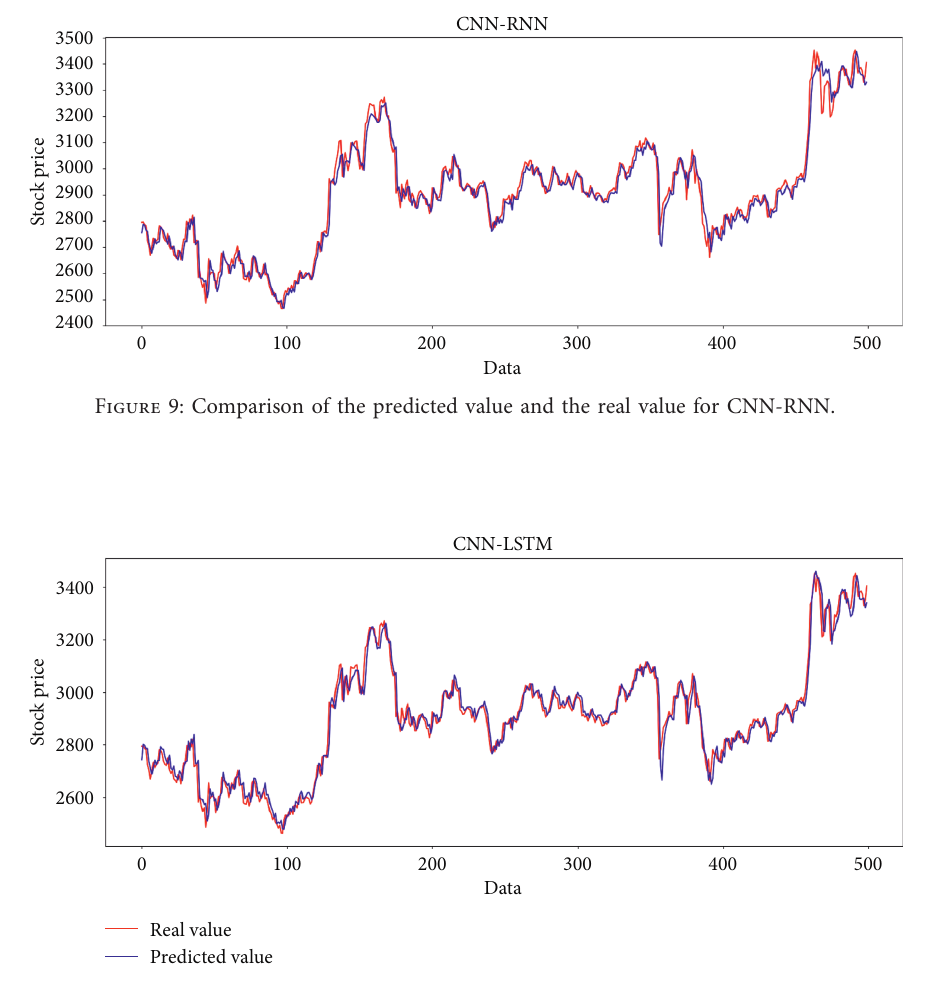
Figure 10: Comparison of the predicted value and the real value for